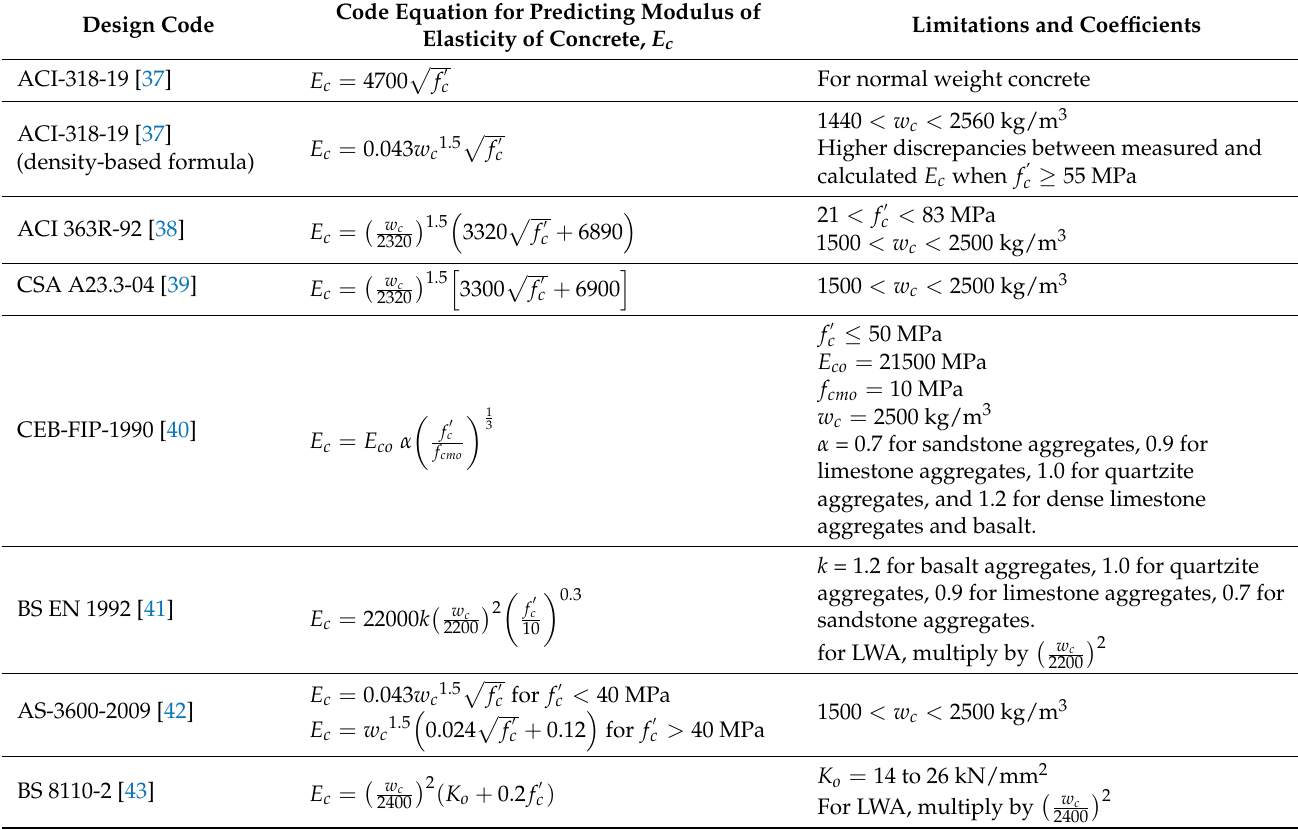
Table 4. Modulus of elasticity prediction models in various building